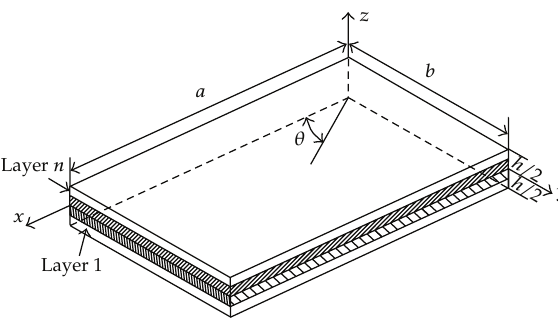
Figure 1: The configuration of a laminated composite